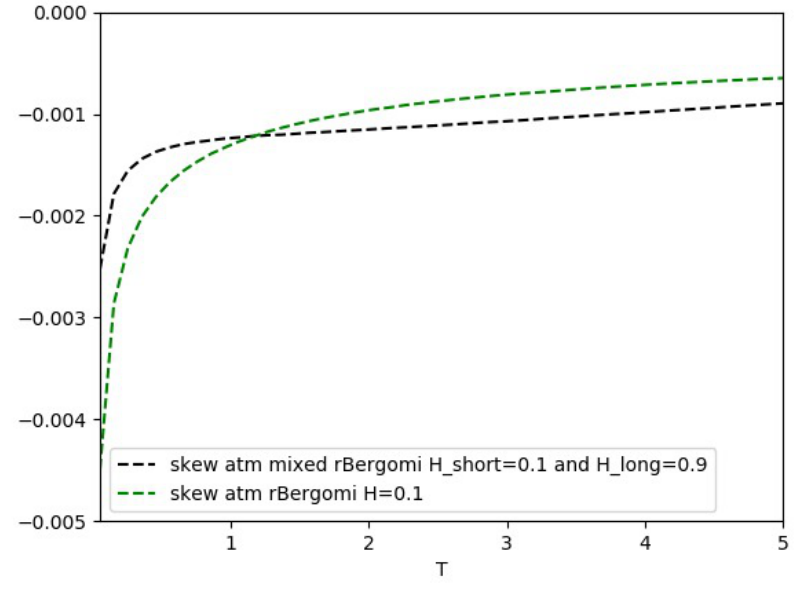
Figure 5. Slope skew for an mfBergomi model and an rBergomi model with H < 1